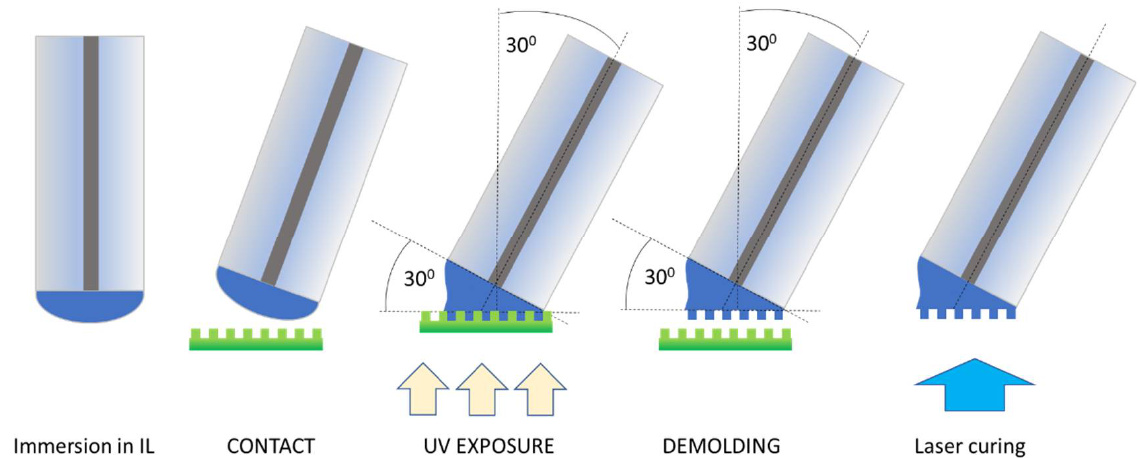
Figure 2. The scheme procedure of a diffraction pattern on a fiber fabrication.